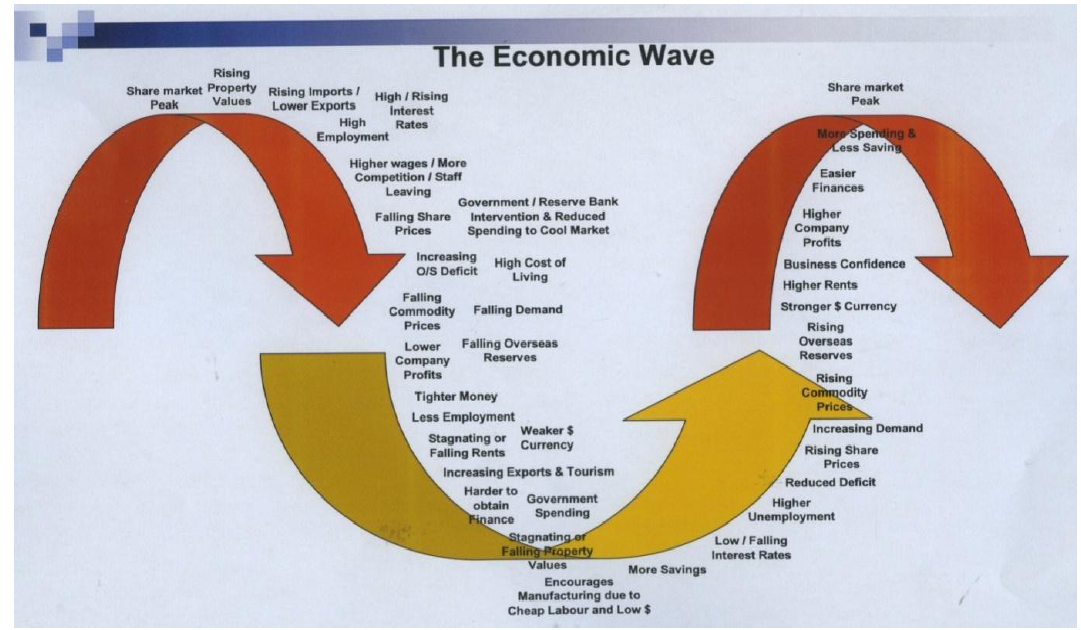
Figure 148 The Economic Waves Source: